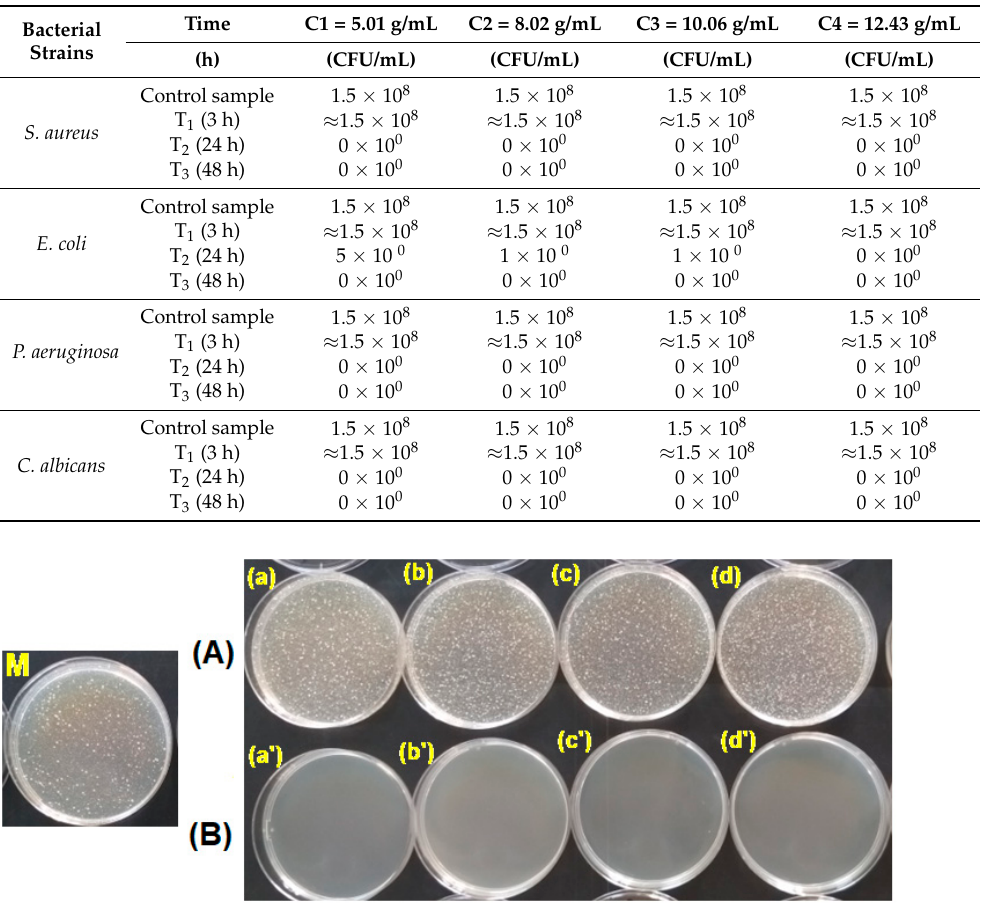
Figure 12. Antimicrobial activity of PSFEtP + polysulfone at different concentrations: C 1 ( a , a’ ), C 2 ( b , b’ ), C 3 ( c , c’ ), C 4 ( d , d’ ) against Staphylococcus aureus for different times, ( A ) T 1 = 3 h and ( B ) T 2 = 24 h, compared to control sample (M).